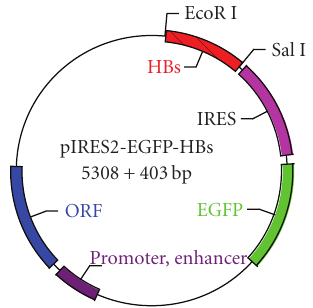
Figure 1: Diagram of constructed recombinant plasmid pIRES2-